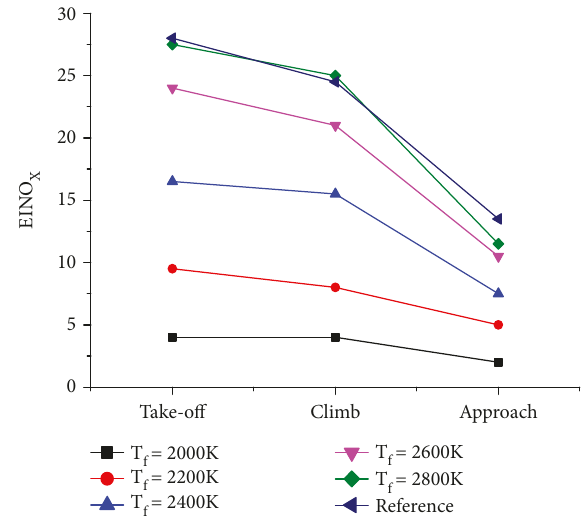
Figure 17: E ff ect of di ff erent T